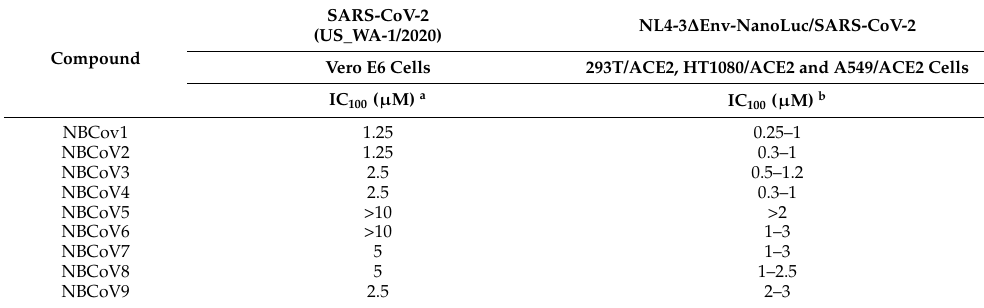
Table 5. Antiviral activity (IC 100 ) of the NBCoV small molecules in Vero E6 cells infected with SARS-CoV-2 (US_WA-1/2020) and the range of IC 100 detected in the three cell lines